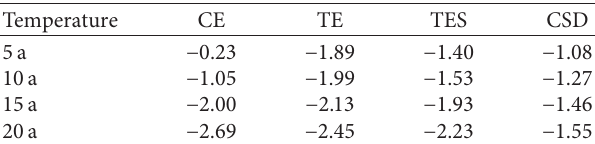
Figure 12: Distribution of the temperature field beneath the SE with the sand deposition thickness of 0.7 m in cold season of 5a, 10a, 15a, and 20a (unit: ° C). Table 6: Variation of the permafrost table beneath the SE with the sand thickness of 0.3 m in October 15th of 5th, 10th, 15th, and 20th years (unit: m).